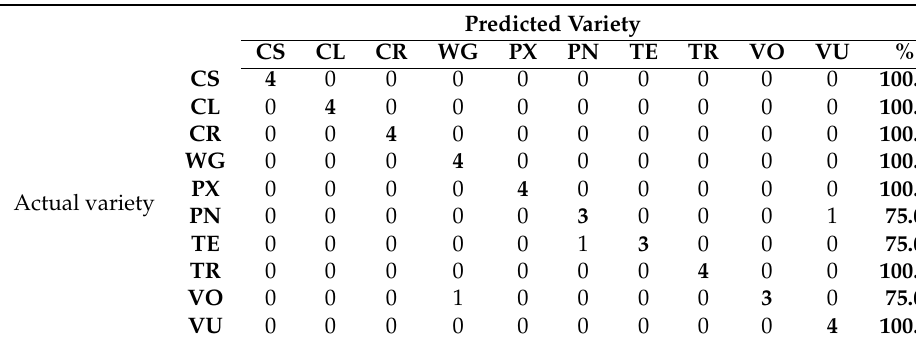
Table 3. Confusion matrix of grapevine varietal classification using support vector machines and an external validation of 40 samples. The diagonal of the matrix corresponds to the number of samples that were properly classified. The last column displays, for each variety, the correctly classified percentage (n = 40).